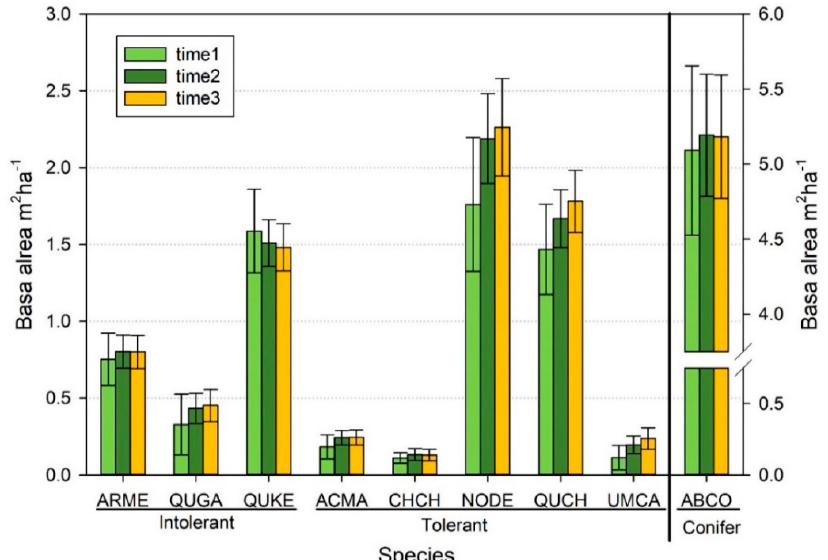
Figure 5. Species basal area across three time periods, National Forest System (NFS), and private lands only. Species codes are first two letters of genus and species, order of shade-intolerants on the left and shade-tolerants on the right used in all figures; white fir (a conifer) is shown for comparison using a second y-axis on the right. Error bars represent 95% confidence